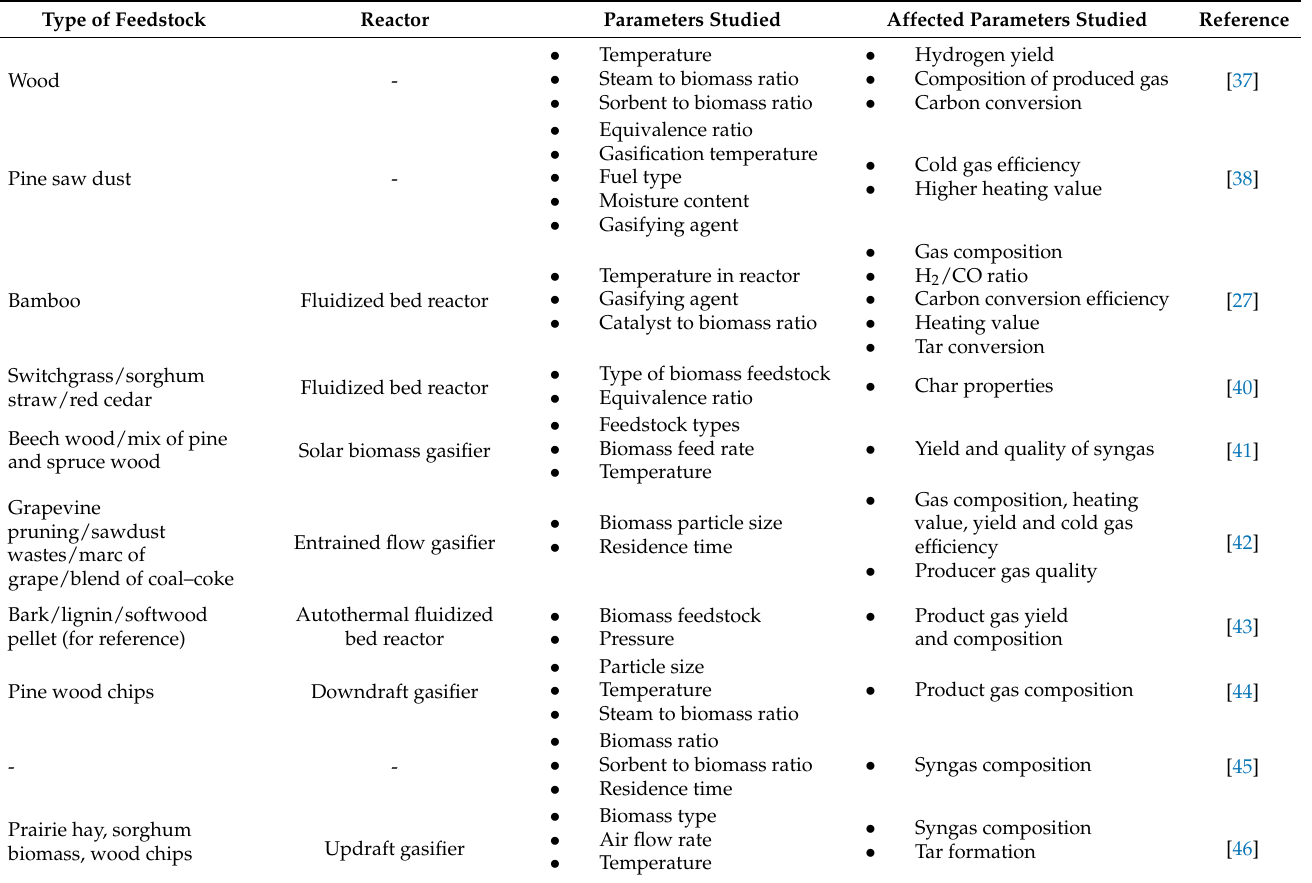
Table 1. Summary of parametric studies on biomass